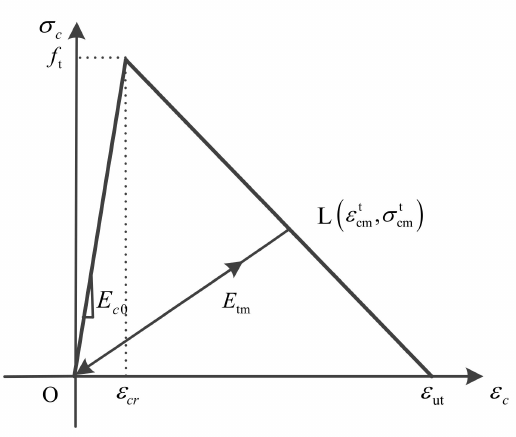
Figure 6. Tensile model of concrete.